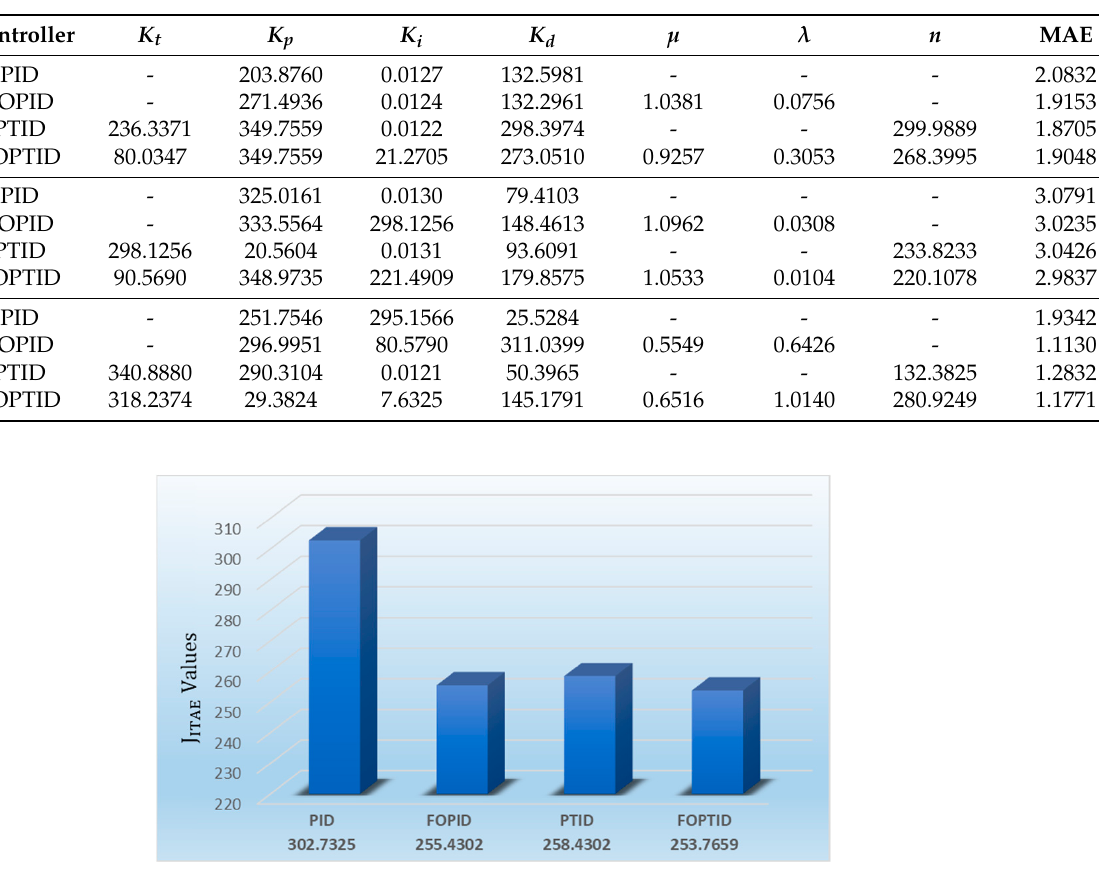
Table 1. Comparison of the optimized parameters of the controllers and MAE values for each joint.